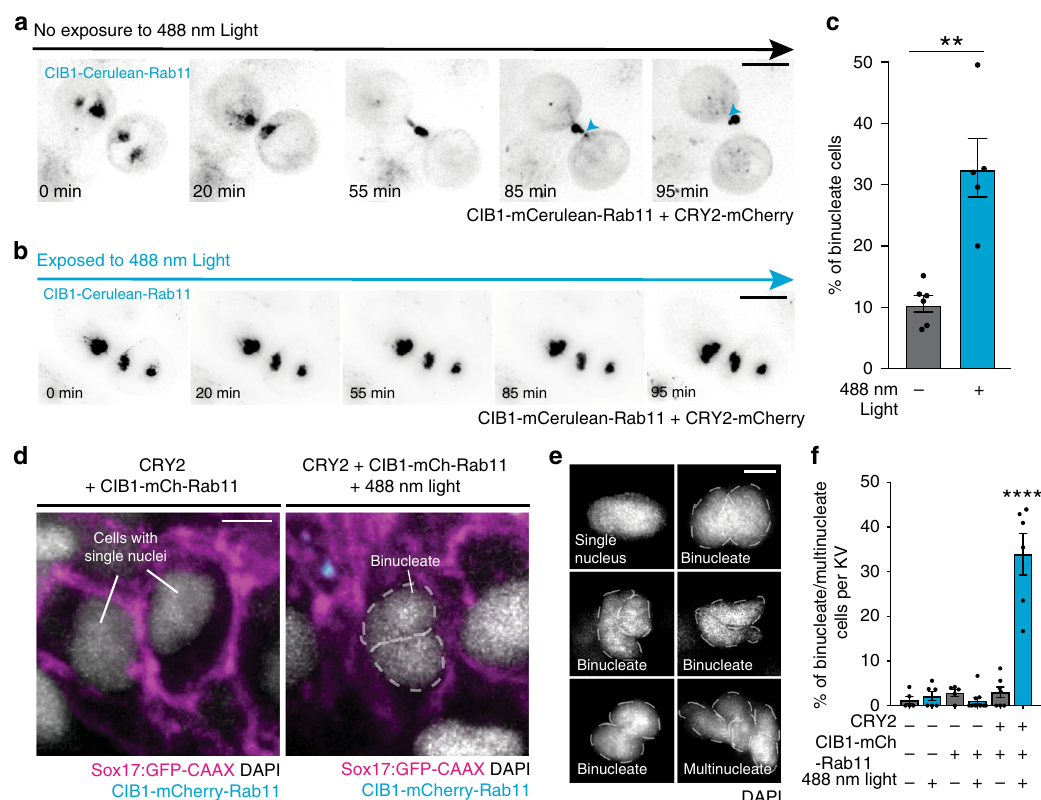
Fig. 5 Optogenetic clustering of Rab11-associated vesicles results in failed abscission in vitro and in vivo. a , b Time-lapse of cytokinetic HeLa cells transfected with CRY2-mCherry and CIB1-mCerulean-Rab11 (black) in the absence ( a ) or presence of 488 nm light ( b ). Bar, 10 μ m. Note the cleavage events of cytokinetic bridge (blue arrows, a ), but not in b . c Bar graph depicting the percentage of total HeLa cells displaying a binucleate phenotype after being released from a metaphase synchronization for 2 h in the presence or absence of 488 nm light. Cells were transfected with CRY2-mCherry and CIB1- mCerulean-Rab11 as in a . Unpaired, two-tailed Mann – Whitney test, ** p = 0.0043. Mean displayed± SEM. n = 100 cells per treatment for n > 5 experiments. Dots represent individual values. Statistical results detailed in Supplementary Table 5. d A 3D rendering of embryos expressing CRY2 and CIB1-mCherry-Rab11 in the absence (left) and presence (right) of 488 nm light. Sox17:GFP-CAAX (magenta), CIB1-mCherry-Rab11 (cyan), and nuclei (DAPI — white) shown. Bar, 5 μ m. e Representative images of single nuclei, binucleate, or multinucleate cells. Nuclei shown in grayscale (DAPI). Bar, 5 μ m. f Bar graph depicting percentage of binucleate and/or multinucleate cells per KV in uninjected embryos and embryos expressing CIB1-mCherry-Rab11 or CRY2 and CIB1-mCherry-Rab11 plus or minus 488 nm light. One-way ANOVA with Dunnett ’ s multiple comparison test used, compared with uninjected embryos in the absence of 488 nm light exposure. Statistical results detailed in Supplementary Table 5. Analyses performed in n > 5 embryos over three experiments. Mean displayed ± SEM. Dots represent individual